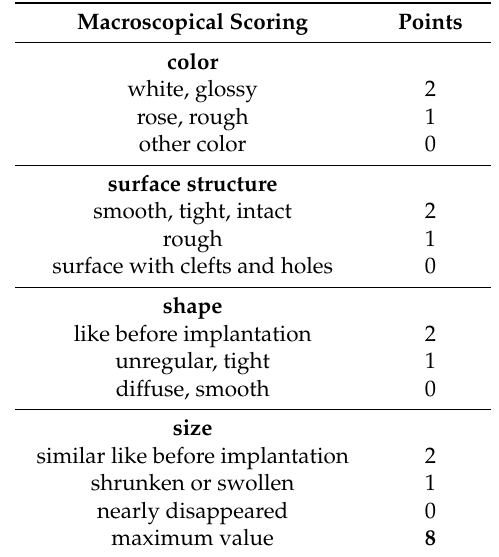
Table 1. Macroscopical scoring system for tendon explants.